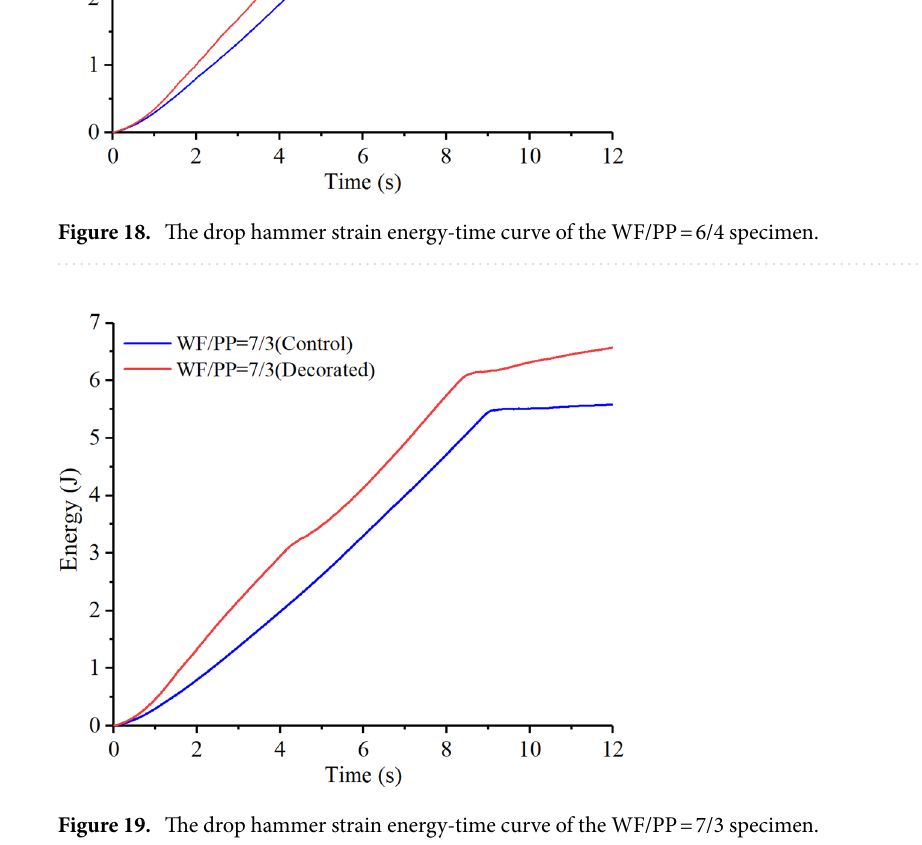
Figure 19. The drop hammer strain energy-time curve of the WF/PP = 7/3 specimen.